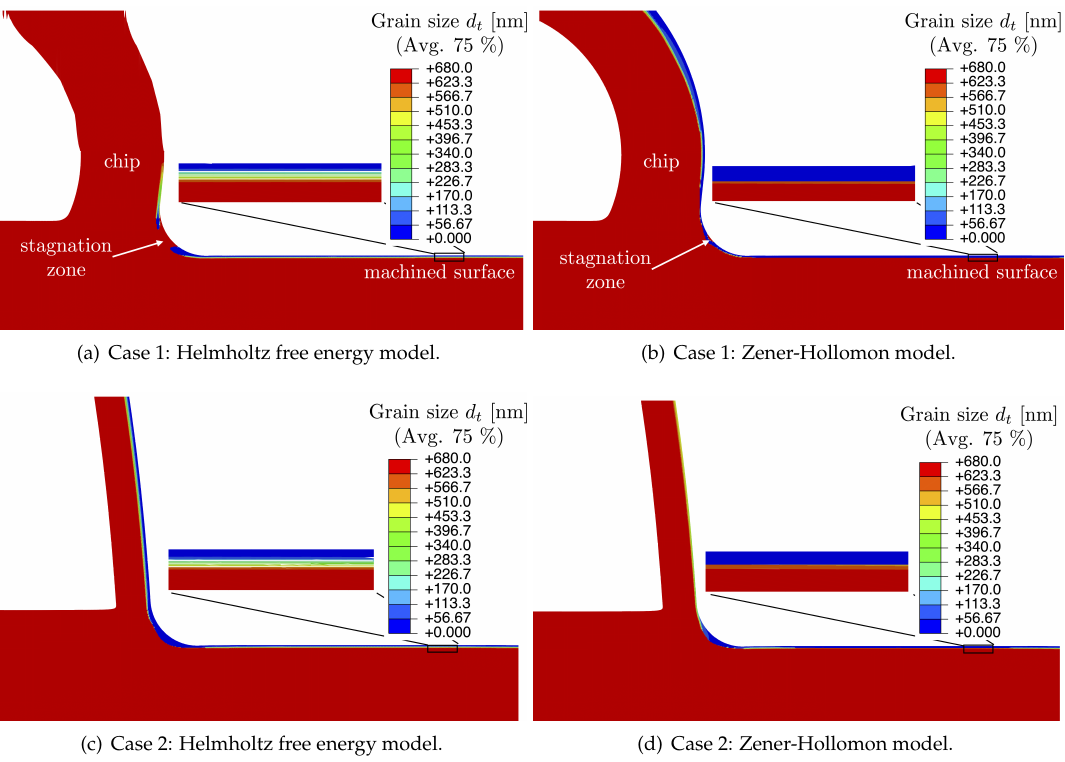
Figure 4. Prediction of grain size d t via Helmholtz energy and Zener-Hollomon models at investigated cases 1 and